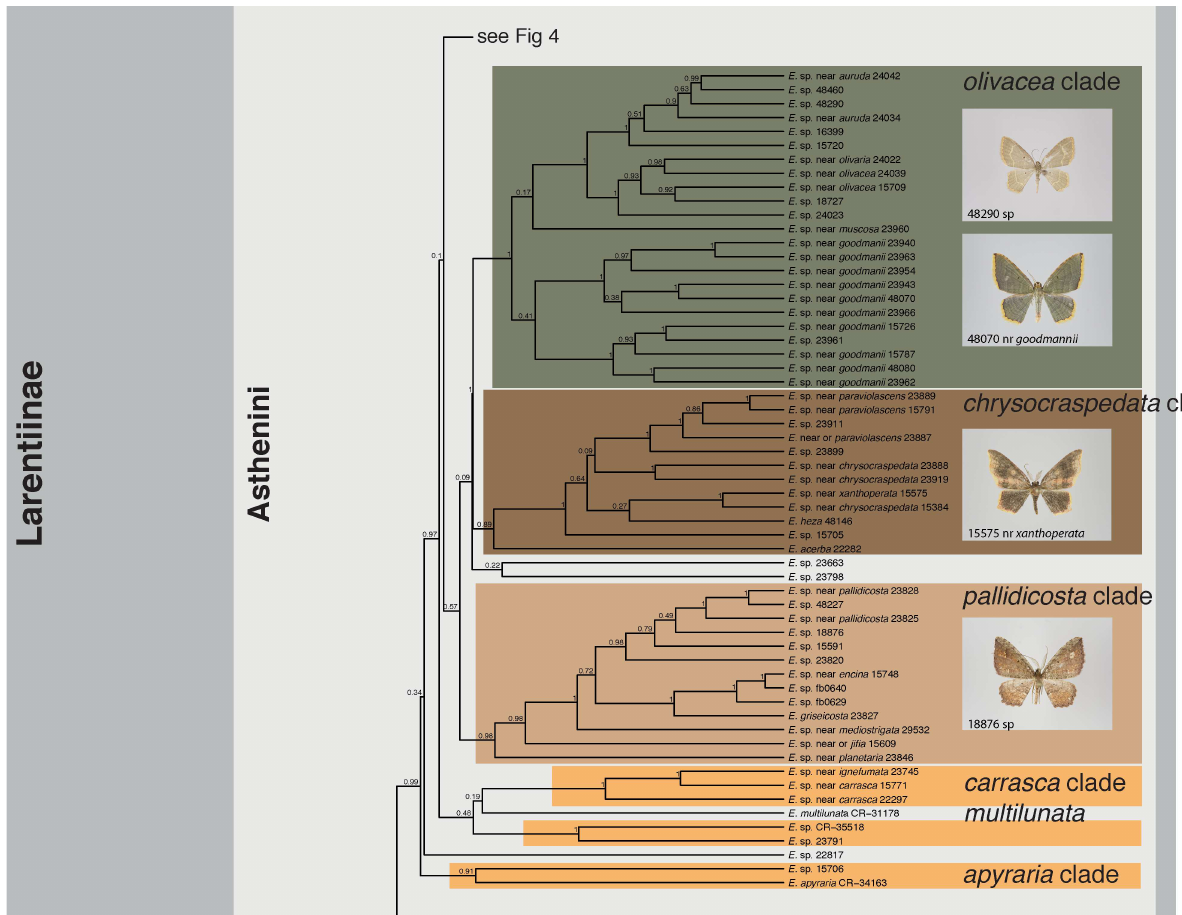
Fig 3. Phylogenetic tree obtained from BEAST, Part 3. All informally named infrageneric clades are indicated along with photographs of select members of each clade within Neotropical Eois . Bayesian posterior probabilities are given at nodes.